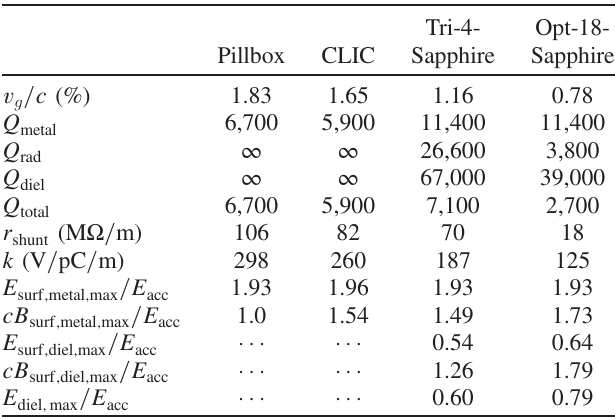
TABLE I. Figures of merit for the accelerating mode in periodic single cell cavities. a ¼ 3 . 15 mm, d ¼ 1 . 67 mm, ϕ ¼ 2 π = 3 . All simulations performed at Δ z=d ¼ 8 .